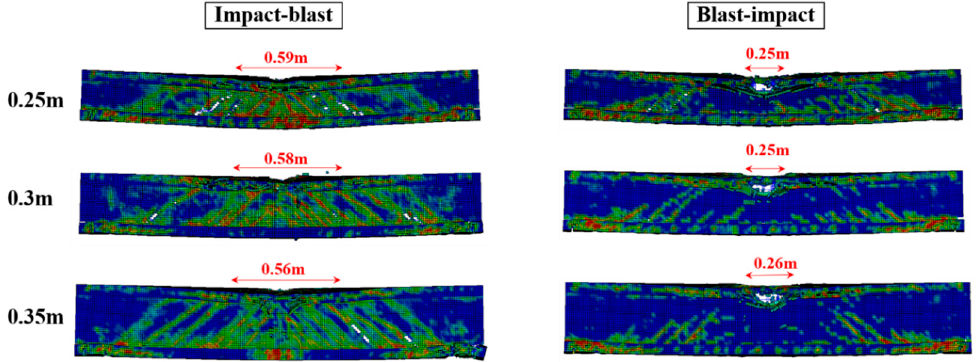
Figure 11. Damage states of beams under combined loads of different beam depths.